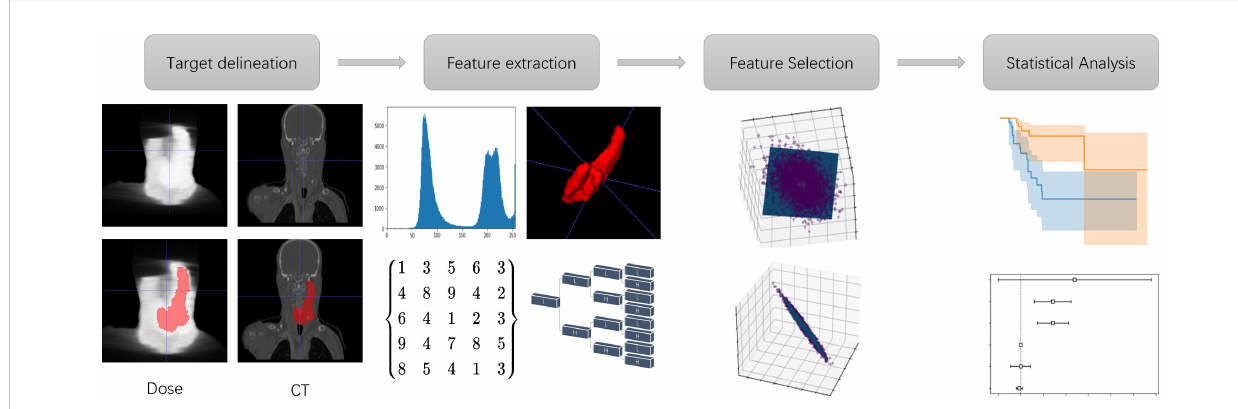
FIGURE 1 The fl owchart of building the statistical analysis